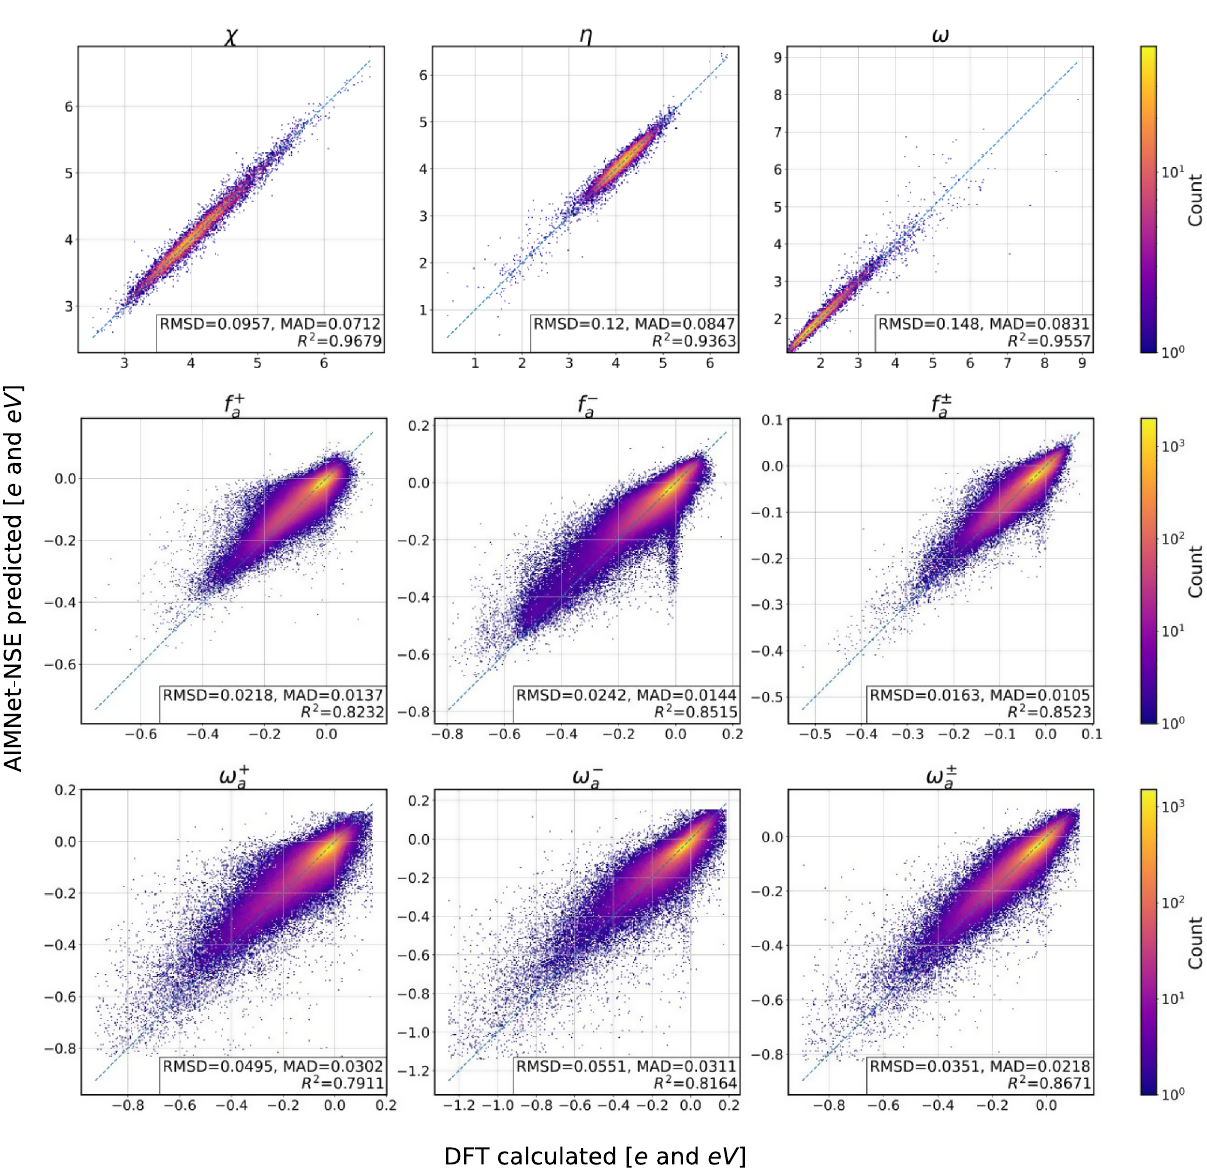
Fig. 4 Conceptual DFT quantities predicted by the AIMNet-NSE model. Correlation between DFT PBE0/ma-def2-SVP and AIMNet-NSE predictions for electronegativity ( χ ), chemical hardness ( η ) and electrophilicity index ( ω ), Fukui coef fi cients for nucleophilic ( f þ a ), for electrophilic ( f (cid:2) a ) and radical ( f ± a ) attacks and three corresponding condensed philicity indexes ( ω a ) for Ions-16 data